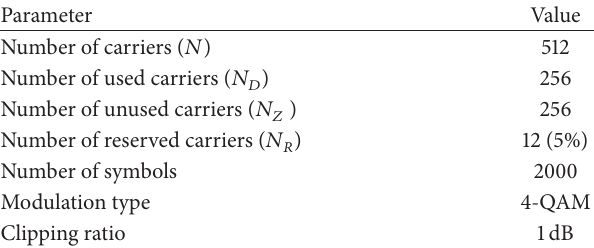
Table 1: Simulation parameters of the FBMC signal and the PAPR reduction schemes.